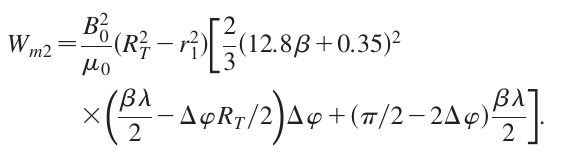
FIG. 13. Analytically calculated stored energies as a function of (cid:2) .